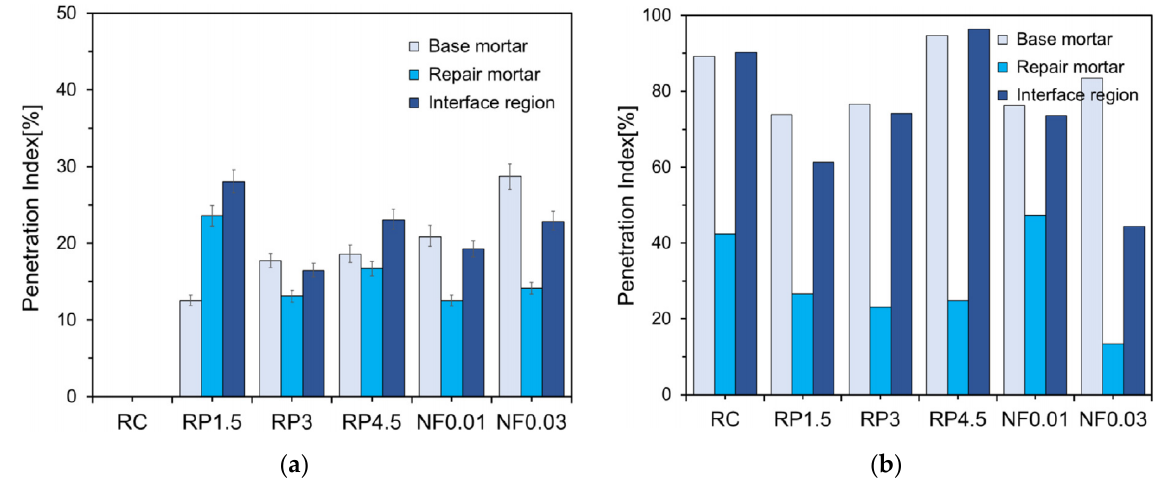
Figure 14. Penetration indices of the accelerated water tightness test after ( a ) sulfuric acid immersion and ( b ) freeze–thaw cycles [39].